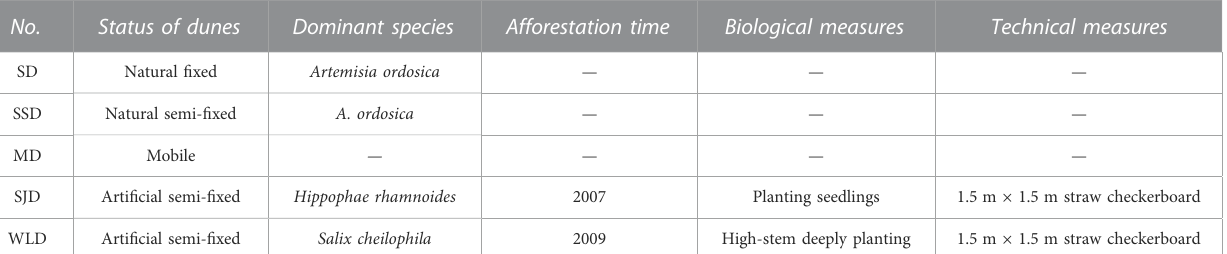
TABLE 1 Study sites in the WPSER.